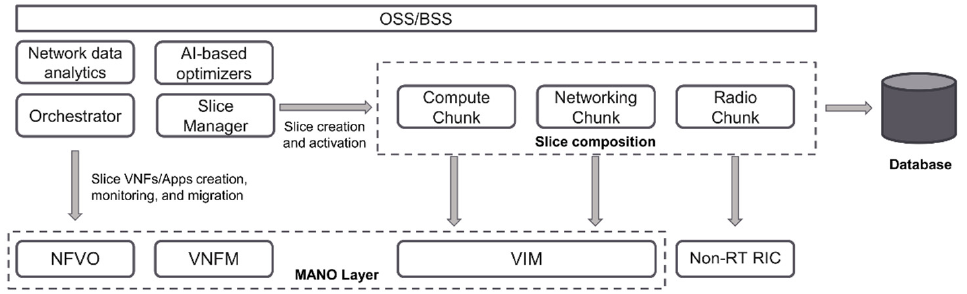
Figure 4. High-level view of the network slicing system.